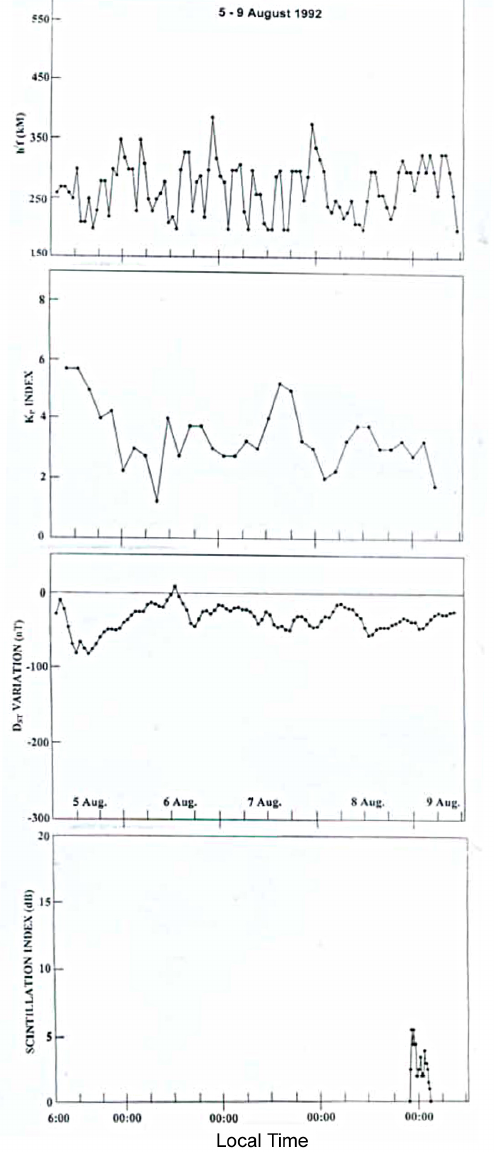
Fig. 11. Example of a magnetic storm that occurred during 05 − 09 August 1992. The top panel is ionospheric F-layer height (h 0 F) at Ahmedabad, the two middle panels are K p and D st and the bot- tom panel shows the occurrence times of scintillation activity at Varanasi.